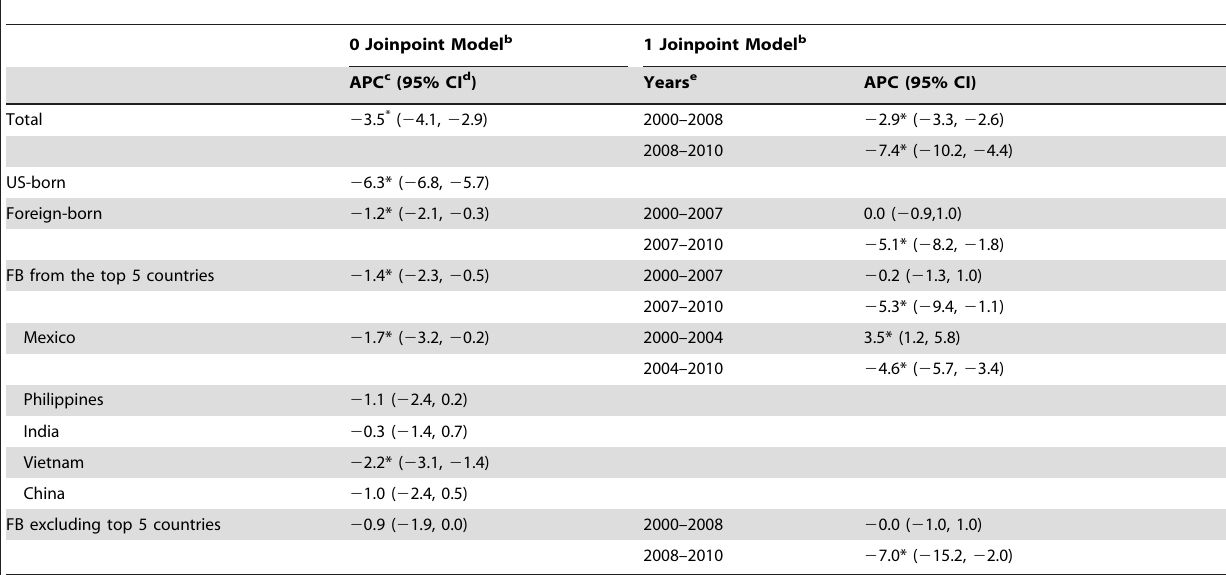
Table 2. Joinpoint a analysis results for significant change in trend among 2000–2010 TB case